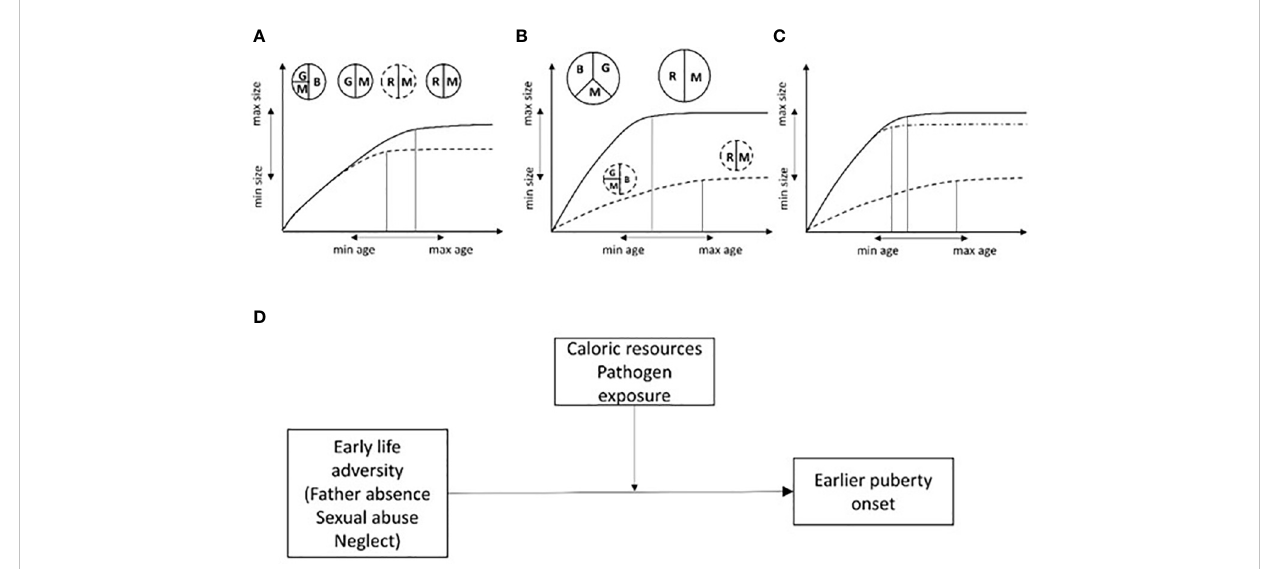
FIGURE 1 Somatic growth vs reproduction trade-offs in energy allocation are expected to in fl uence the relationship between body size and age at sexual maturity. (A) Two individuals with same genotype are exposed to the same caloric resource regimen and pathogen load. Resources will be allocated toward brain and somatic growth and maintenance (immune system). If for some reason (i.e. a new mutation) one of them matures earlier (dashed line), resources will be allocated to reproduction at the expense of somatic growth. (B) Two individuals with the same genotype experiencing different environmental risks (different levels of caloric intake, pathogen load and thus high vs low mortality/morbidity risk). Individuals with less resources will take longer to develop, coming near the latest species-speci fi c limit for sexual maturation but reaching the lower limit for species- speci fi c adult body size (dashed line). On the contrary, the individual with better resources can afford to invest both in brain development, body growth and maintenance, therefore, maturing earlier and becoming bigger (secular trend). (C, D) If conditions threatening child survival/well-being are present, the extent to which these conditions will in fl uence sexual maturation will depend on caloric resources and pathogen load (i.e. the amount of resources available for somatic growth, maintenance and reproduction). In poor environments, psychological and social threats are expected to have a small and negligible effect on sexual maturation while in resource-richer conditions higher adversity is predicted to speed up sexual maturation relative to conditions of low psychosocial threat. This is represented by the dashed-dotted line in (C) and by a moderation model in (D) . G, somatic growth; B, brain growth; M, maintenance; R, reproduction. Size of circles and slices are proportional to the amount of resources available for the development of different organismal systems. Double arrows indicate the potential span for species-speci fi c age and size at sexual maturity (hypothetical scale). Size of circles, slices and or double arrows are